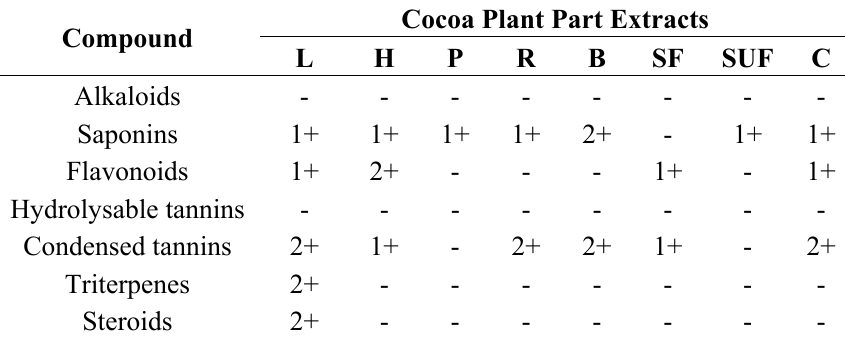
Table 6. Phytochemical constituents of cocoa plant part